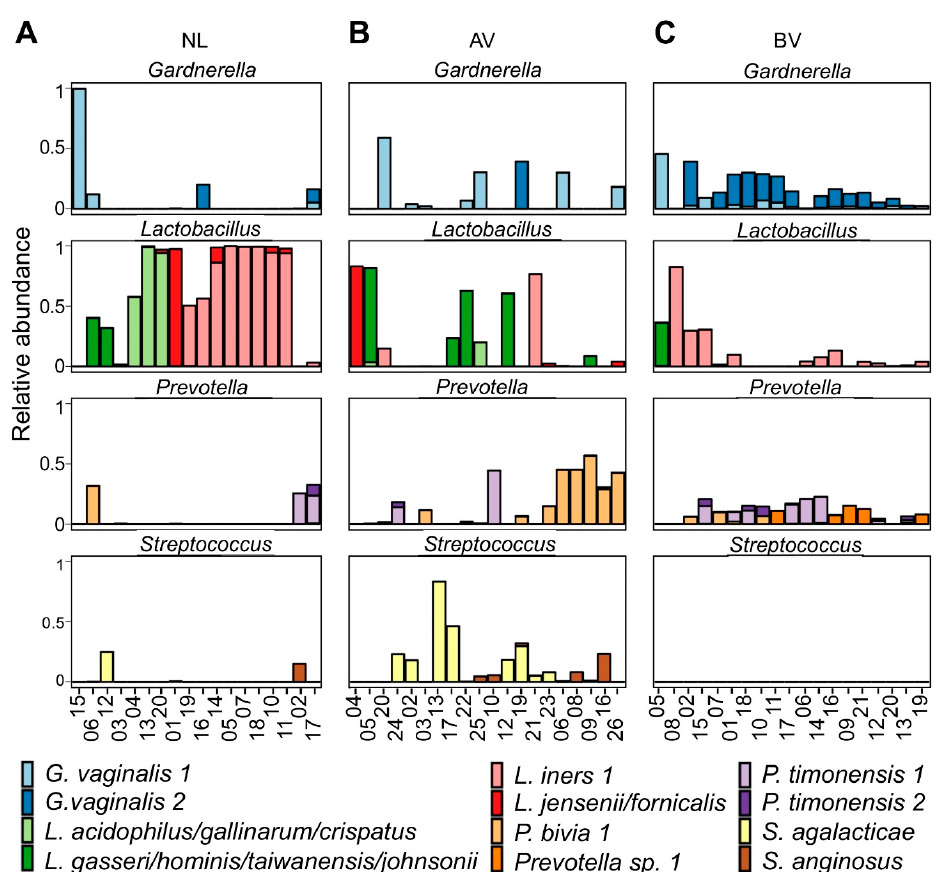
Figure 2. Relative abundances of Lactobacillus, Gardnerella , Prevotella , and Streptococcus ASVs in the NL ( A ), BV ( B ), and AV group ( C ). Bars are colored according to ASV. Only ASVs that accounted for at least 5% of sequences in at least two samples are visualized. ASVs were classified by EZBioCloud (27) as the closest matching species (allowing for a maximum of two mismatches). AV: aerobic vaginitis, BV: Bacterial Vaginosis, NL: reference group with a normal lactobacillary microbiota (Lactobacillary grade I-IIa, no signs of AV or BV) according to microscopy.